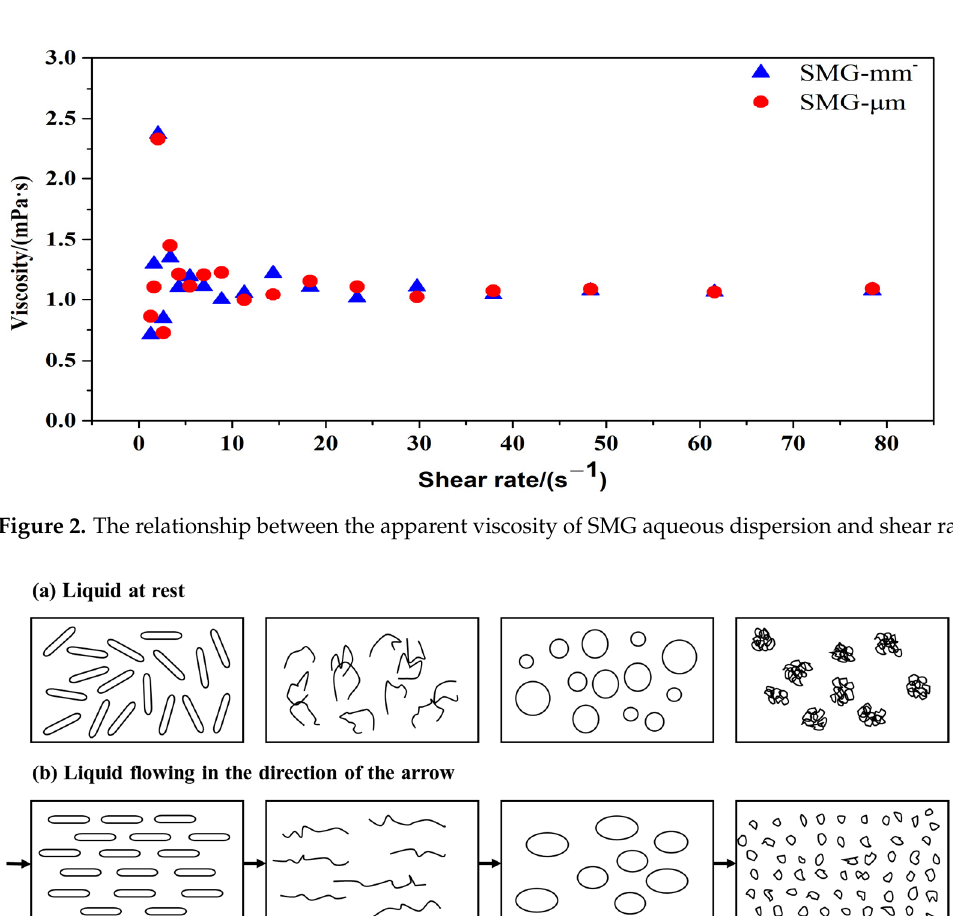
Figure 3. Schematic diagram of the flexible particle system stationary and flowing through the